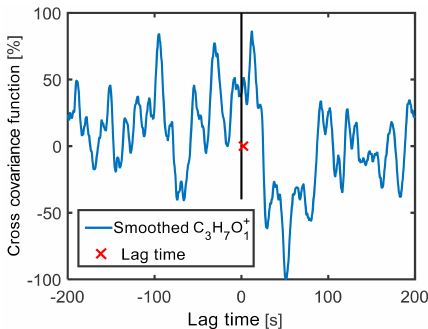
Figure A3. Smoothed normalized CCF of C 3 H 7 O + marks the lag time used in the original CCF (Fig. A4) to find the flux value; the allowed lag time window is from 0 to 5s. In this specific CCF only a local maximum was found, as there is no clear